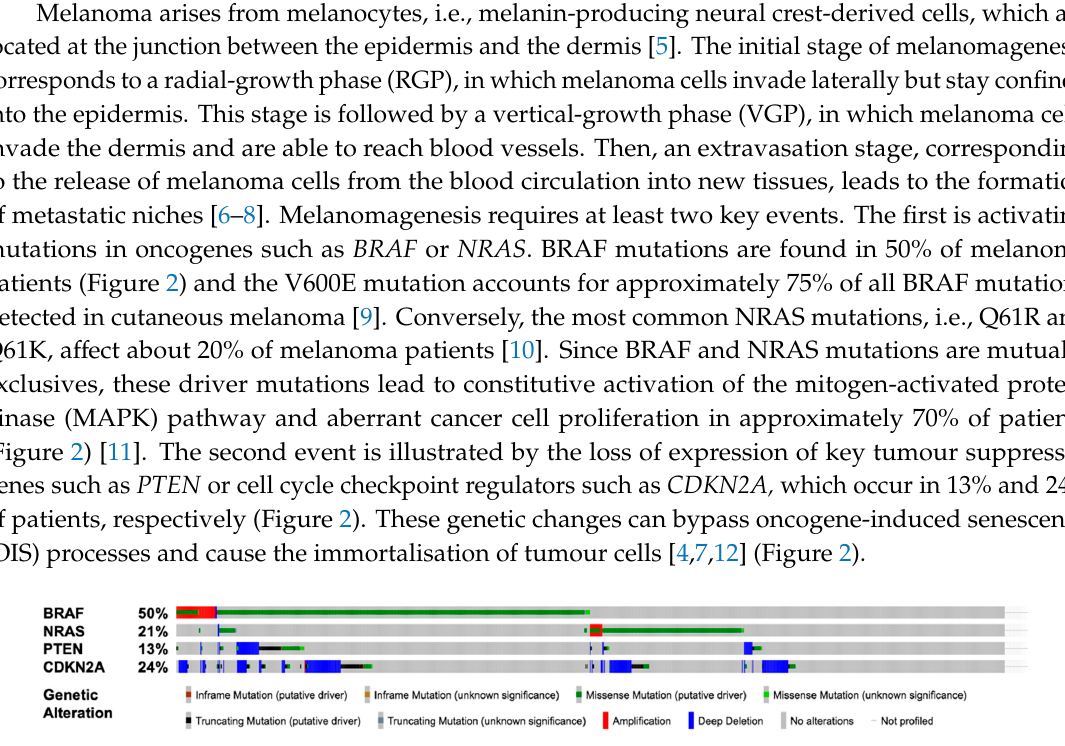
Figure 1. Cutaneous melanoma: the 19th most common cancer worldwide. Estimated age-standardised incidence rates of cutaneous melanoma in the most affected countries in 2018, for both sexes and all ages. Data from the International Agency for Research on Cancer (World Health Organisation).